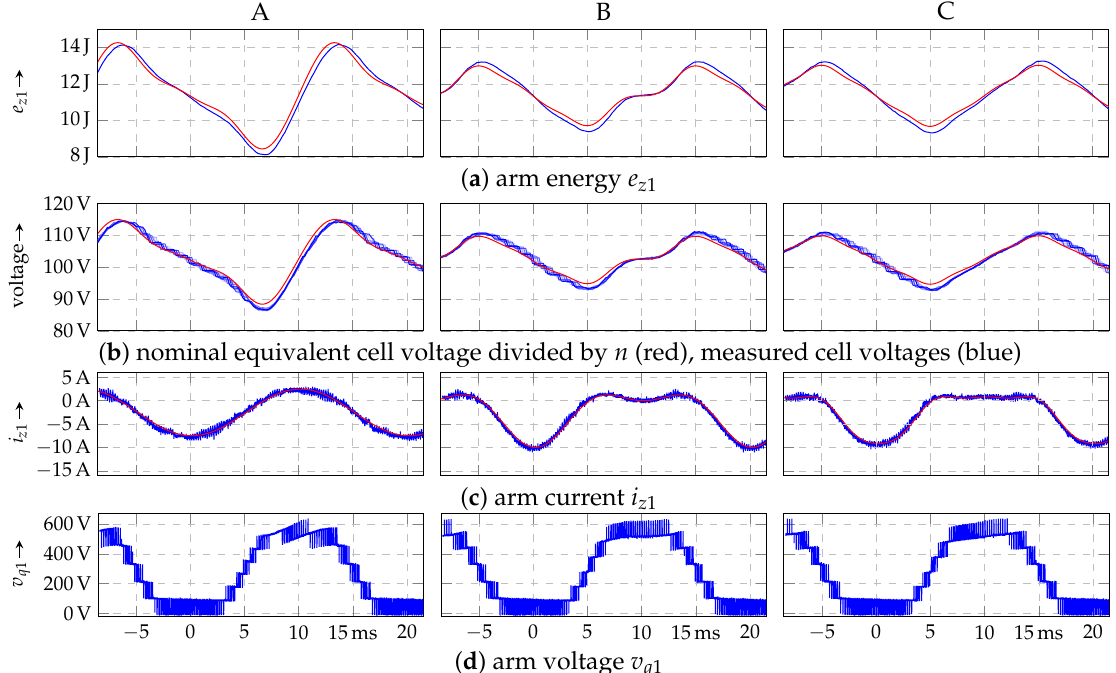
Figure 9. Comparison of Pareto optimal solutions with λ V Tz = 4.522V, ˆ I = 10A, φ = 0°, and m = 1: ( a ) Arm energy e z 1 , ( b ) cell voltages, and scaled nominal equivalent cell voltage, ( c ) arm current i z 1 , ( d ) and injected arm voltage v q 1 . Nominal values are shown in red, measured values in blue. Measured ( c ) current and ( d ) voltage via oscilloscope (LeCroy 24MXs-B), using high bandwidth current probe (LeCroy AP015) and voltage probe (Testec TT-SI 9110).